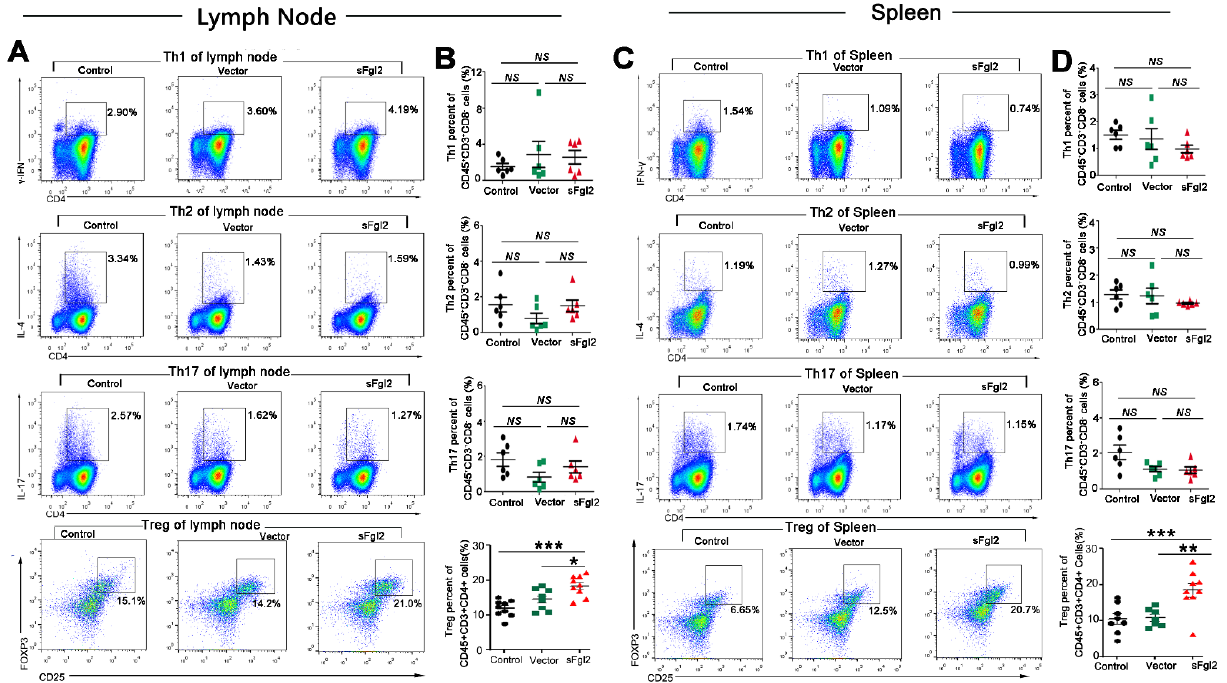
Figure 3. sFgl2-AAV increased the proportion of Tregs and had no impact on Th1, Th2, and Th17 cells’ percentage in the lymph nodes and spleen of atherosclerotic mice. ( A ) Representative flow cytometry analysis of Th1 (CD45 + CD3 + CD8 - CD4 + IFN- γ + ), Th2 (CD45 + CD3 + CD8 - CD4 + IL-4 + ), Th17 (CD45 + CD3 + CD8 - CD4 + IL-17 + ), and Treg (CD45 + CD3 + CD4 + CD25 + Foxp3 + ) cells in spleen of PBS-, Vector-AAV-, and sFgl2-AAV- tail-vein-injected ApoE -/- mice. Left plots show gating of IFN- γ + , IL-4 + , IL-17 + , and Foxp3 by FCM. ( B ) Quantification results of ( A ). ( C , D ) Representative flow cytometry analysis and quantification results of Th1, Th2, Th17, and Treg cells in lymph nodes of the above mice. NS = Not significant, * p < 0.05, ** p < 0.01, *** p < 0.001. Data were represented as mean ±